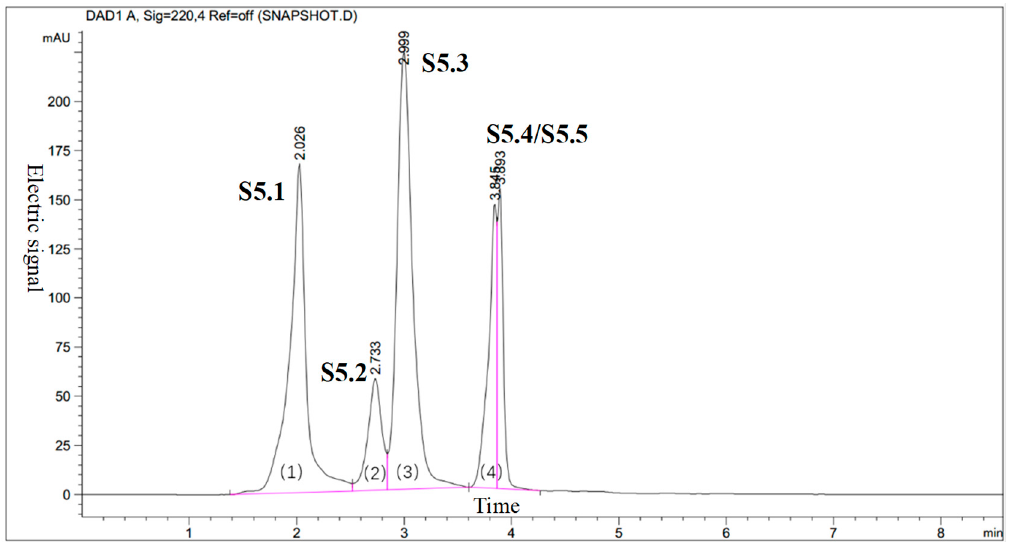
Figure 3. Reverse phase-high performance liquid chromatography (RP-HPLC) chromatogram of fraction F5 (five subfractions, S5.1–S5.5, were collected).